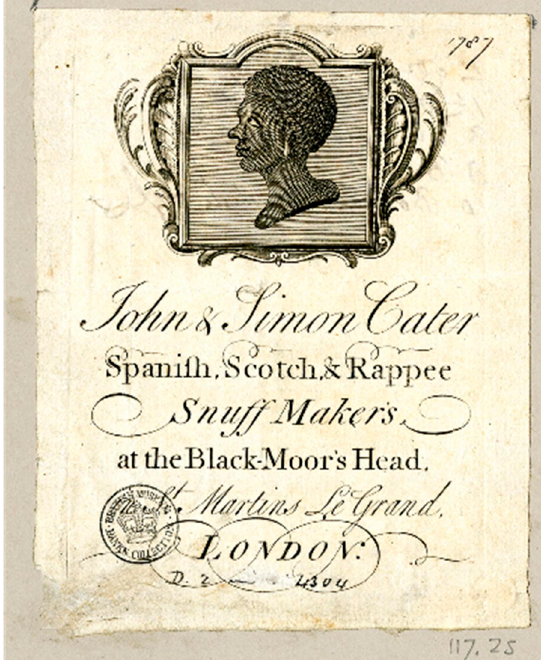
Figure 6. Trade card of John and Simon Cater, snuff makers (Banks, 117.25). © The Trustees of the British Museum.